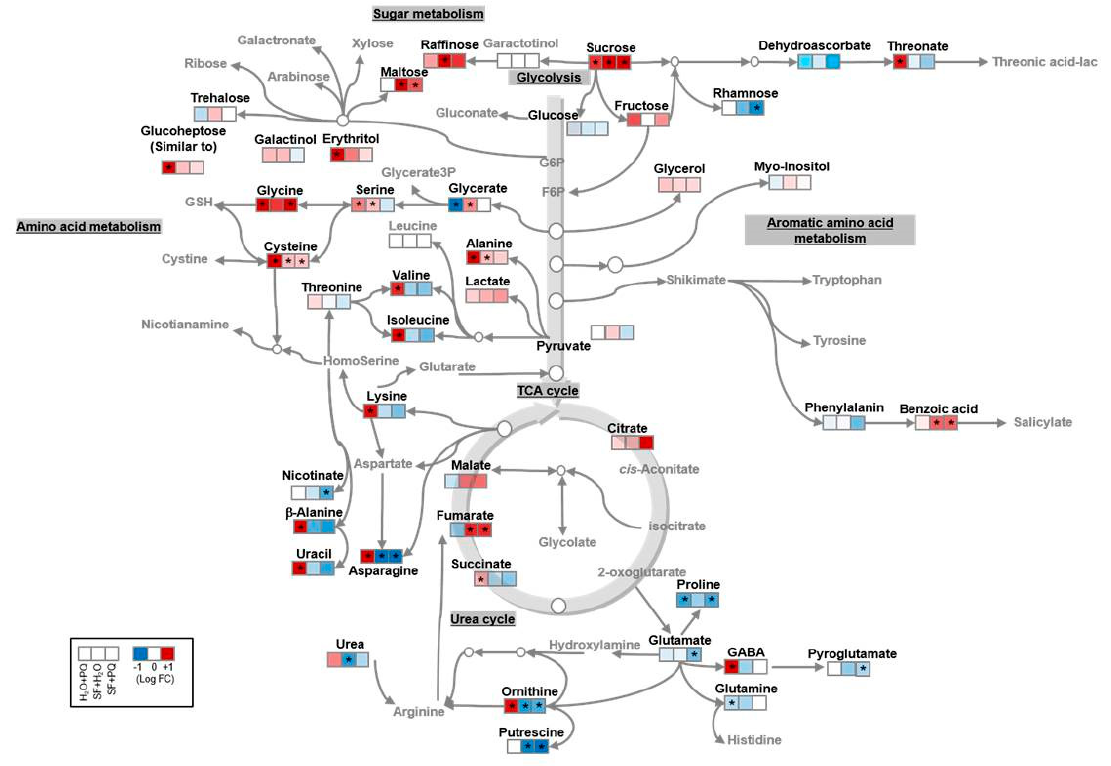
Figure 6. Primary metabolism pathways affected by oxidative stress in SF-primed and -unprimed plants. Changes in primary metabolite abundances in Arabidopsis leaves upon foliar spray with PQ and/or SF measured by GC-MS. Blue and red depict decreases and increases, respectively (log 2 fold change), compared to the control (unprimed and unstressed, i.e., H 2 O + H 2 O). The data are averages of seven biological replicates. Samples: PQ-stressed (H 2 O + PQ), SF-primed, but unstressed (SF + H 2 O), and SF-primed and stressed (SF + PQ). Statistically significant differences compared to the control are highlighted by asterisks (at the significance level of 0.05, FDR corrected). Full data are given in Supplementary Materials Data S5.